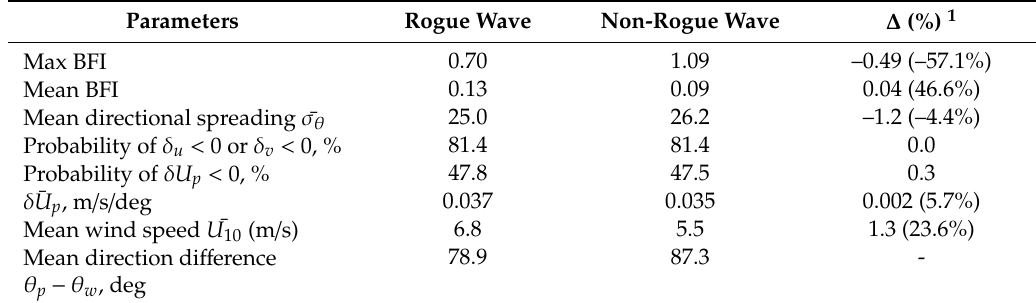
Table A3. Summary of overall statistical analysis.